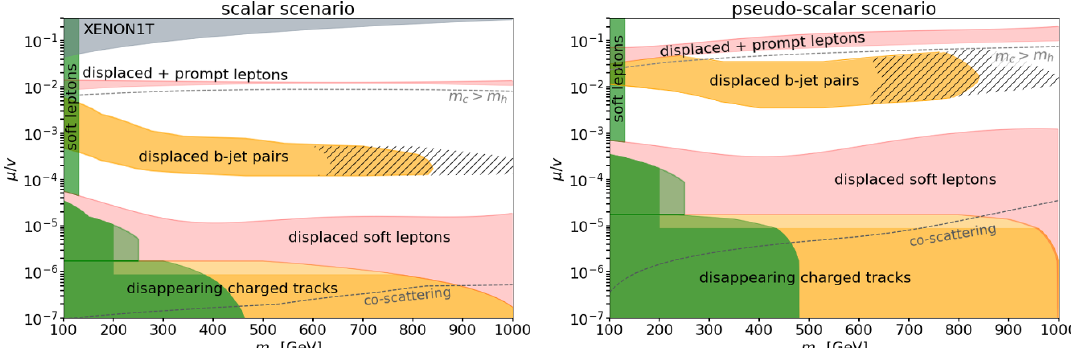
Figure 6 . LHC signatures of fermion dark matter from a small Higgs portal in the scalar (left) and pseudo-scalar (right) scenarios. Green regions are excluded by existing searches. Yellow regions show projections for the LHC after run II and for the HL-LHC. Red regions feature new signatures that have not been explored yet. The dashed region is due to the unknown detection e(cid:14)ciency of displaced b